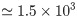
Correlation between ΔP12 and ΔP1 + ΔP1 for ≃1.5×103 pair mutations randomly sampled from an evolved sequence folding to the ensemble shown in S1 Fig.The dashed line is a plot of the equation ϵ = 0. Data points that satisfy either ΔP12 ≥ λ, or ΔP1 ≥ λ and ΔP2 ≥ λ, with λ = −0.2 are colored red (see Text). The remaining data points are colored orange.